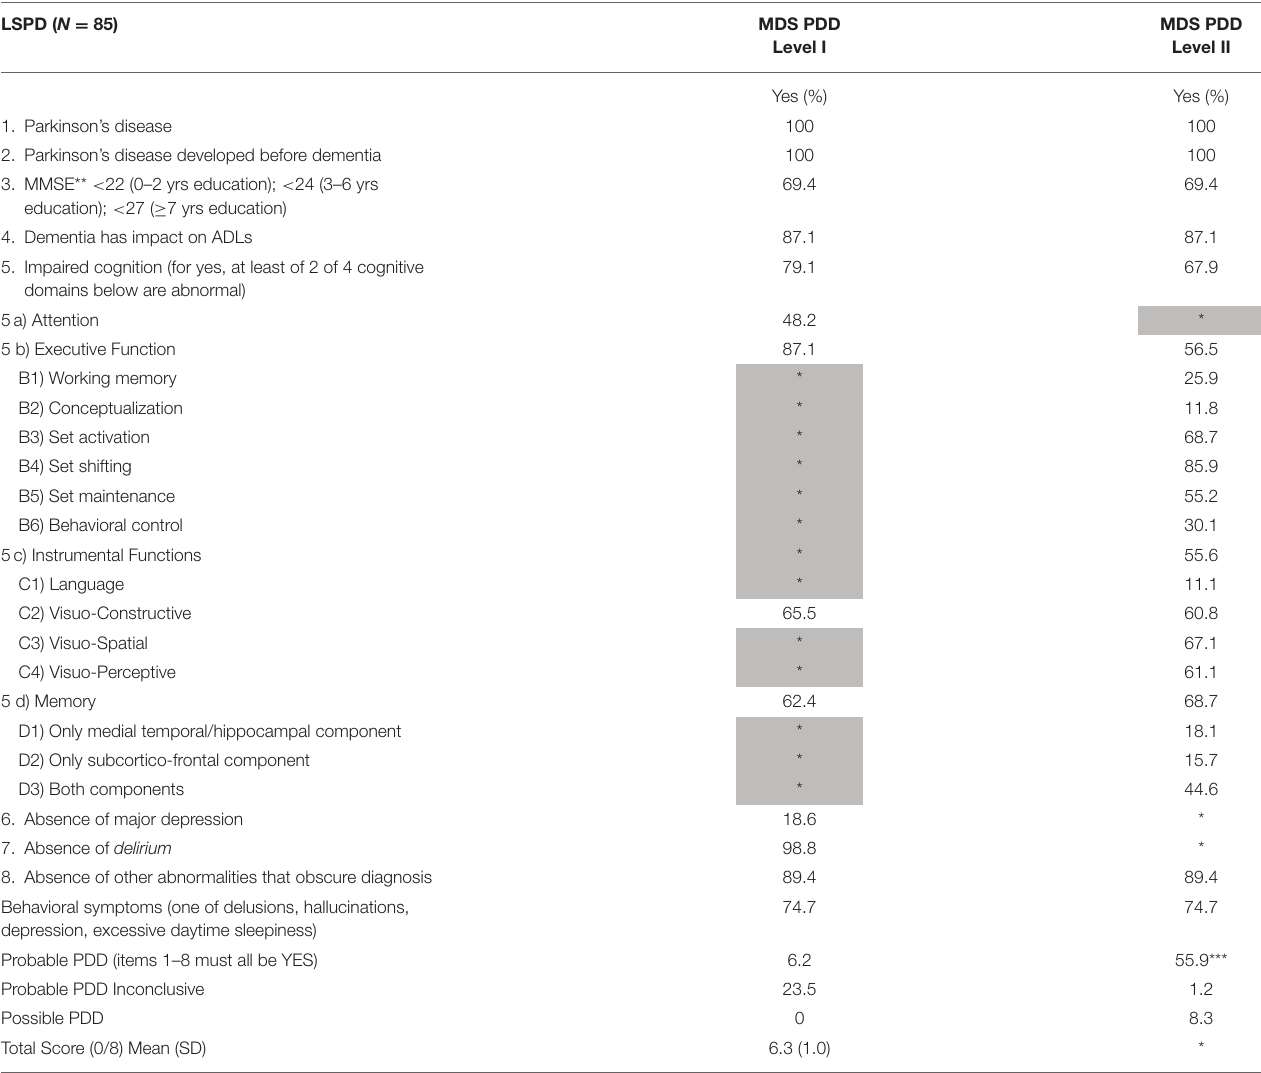
TABLE 3 | Diagnostic rating sheet for Probable PDD recommended by the MDS Task